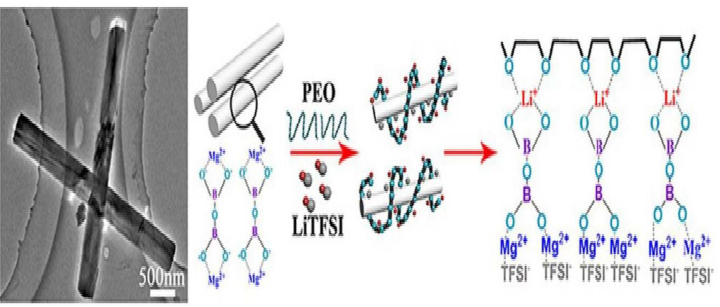
Figure 12. Schematic representation of Li-ion transfer in Mg 2 B 2 O 5 improved based on solid CPEs [110].